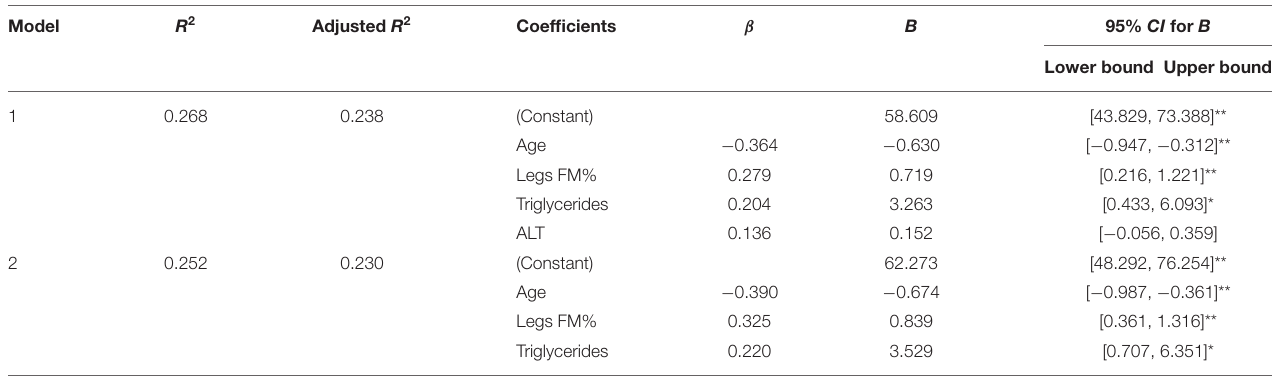
TABLE 4 | Linear (stepwise) regression models for assessing the impact of specific characteristics of coal miners (general, anthropometric, biochemical, and nutritional) on serum 25 (OH) vitamin D levels.